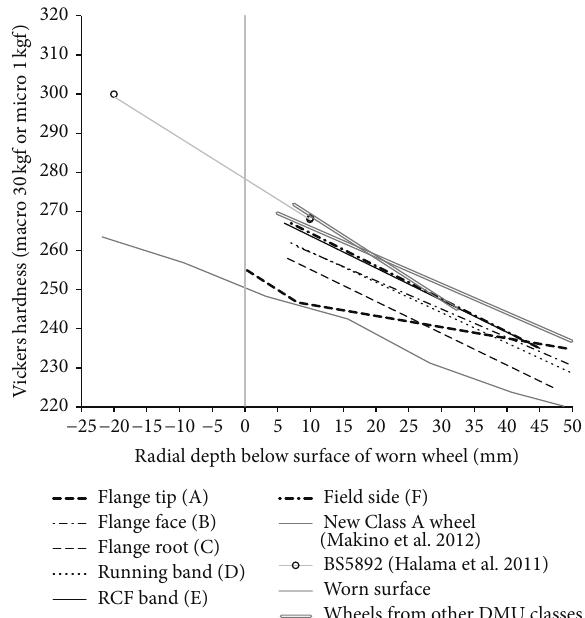
Figure 19: Comparison of underlying hardness trends.